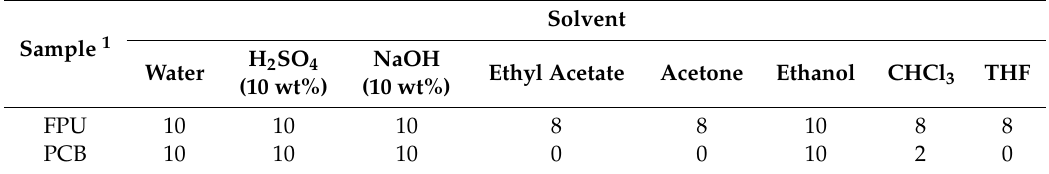
Table 2. Chemical resistance of the fluorinated polyurethane and of poly(CTFE-alt-BVE).